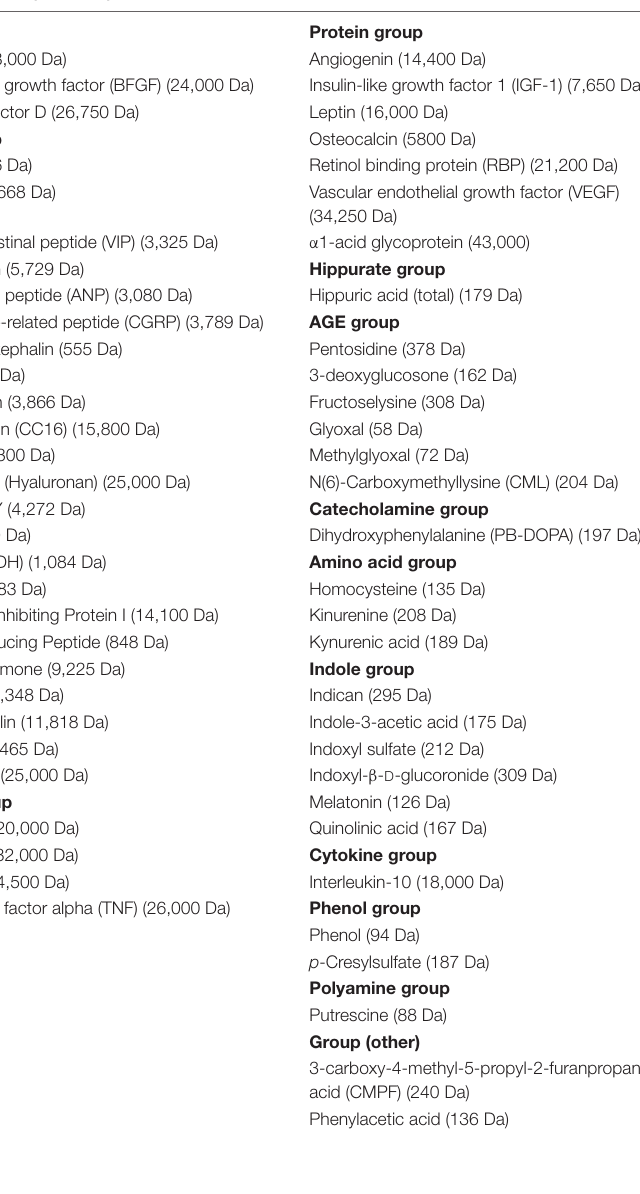
TABLE 2 | Classification of uremic toxins according physical and chemical characteristics. Water-soluble ( < 500 Da) n =